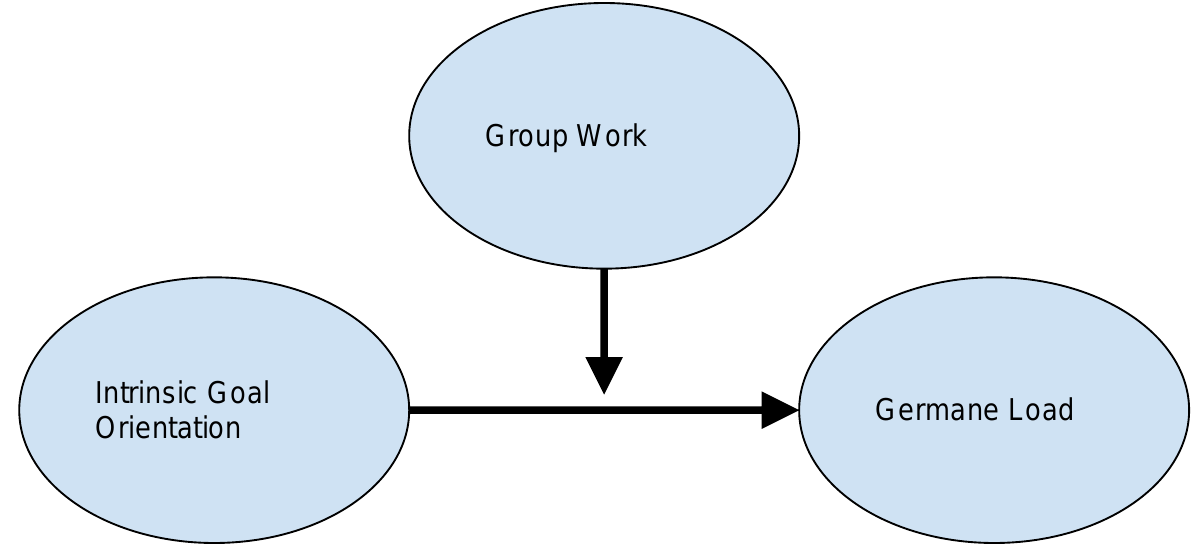
Figure 1. The moderating effects of group work on the relationship between intrinsic goal orientation and germane load.